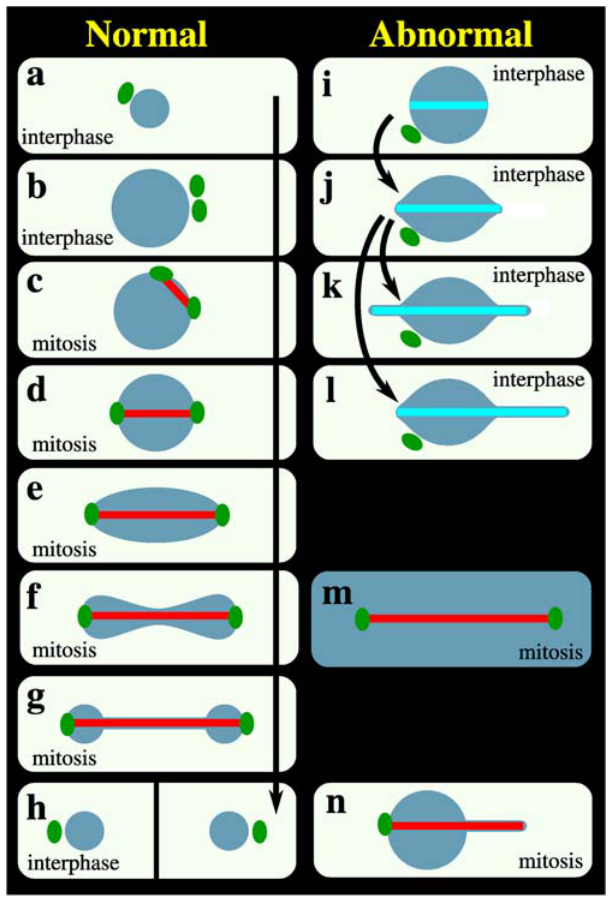
Figure 1. Normal nuclear geometric transformations in the life cycle of fission yeast and a catalogue of fission yeast nuclear abnormal- ities. In interphase (a to b), which lasts for 3–4 hr, the volume of the nucleus increases with time to twice the initial volume of , 4 p / 3 6 1.13 m m 3 . When mitosis begins, the duplicated SPBs (b) are embedded in the NE (c) and as they assume positions on opposite sides of the nucleus (c, d) nucleate the assembly of MTs that form the mitotic spindle. As the spindle elongates (d–f) to a final length of 12– 15 m m [15], the initially spherical nucleus (d), measuring , 1.1 6 2 1/3 m m in radius, is deformed consecutively into an oval (e), peanut (f), and dumbbell (g) shape before resolving into two spherical daughter nuclei (h) , 1.1 m m in radius. Cytokinesis (h) then physically separates the nuclei into two individual cells (a) that initiate another round of cell division. (i to l) Formation and elongation of a n-MTB in interphase cells, leading to formation of one or two tethers, upon ned1 overexpression [6]. (m) NE fragmentation during mitosis, in strains in which the Ran GTPase system is perturbed [reviewed in 35]. (n) During abnormal mitosis in the cut11-2 temperature sensitive mutant [11], the msd1 null mutant [12] or upon mia1 overexpression [13] or laser microsurgery [14], one end of the mitotic spindle has no SPB or is not properly anchored to the SPB and, upon spindle elongation, this end induces a single tether whereas the NE appears undeformed at the other end. Dark blue: nucleus; green: SPB; red: spindle in mitotic cells; turquoise: n- MTB in interphase